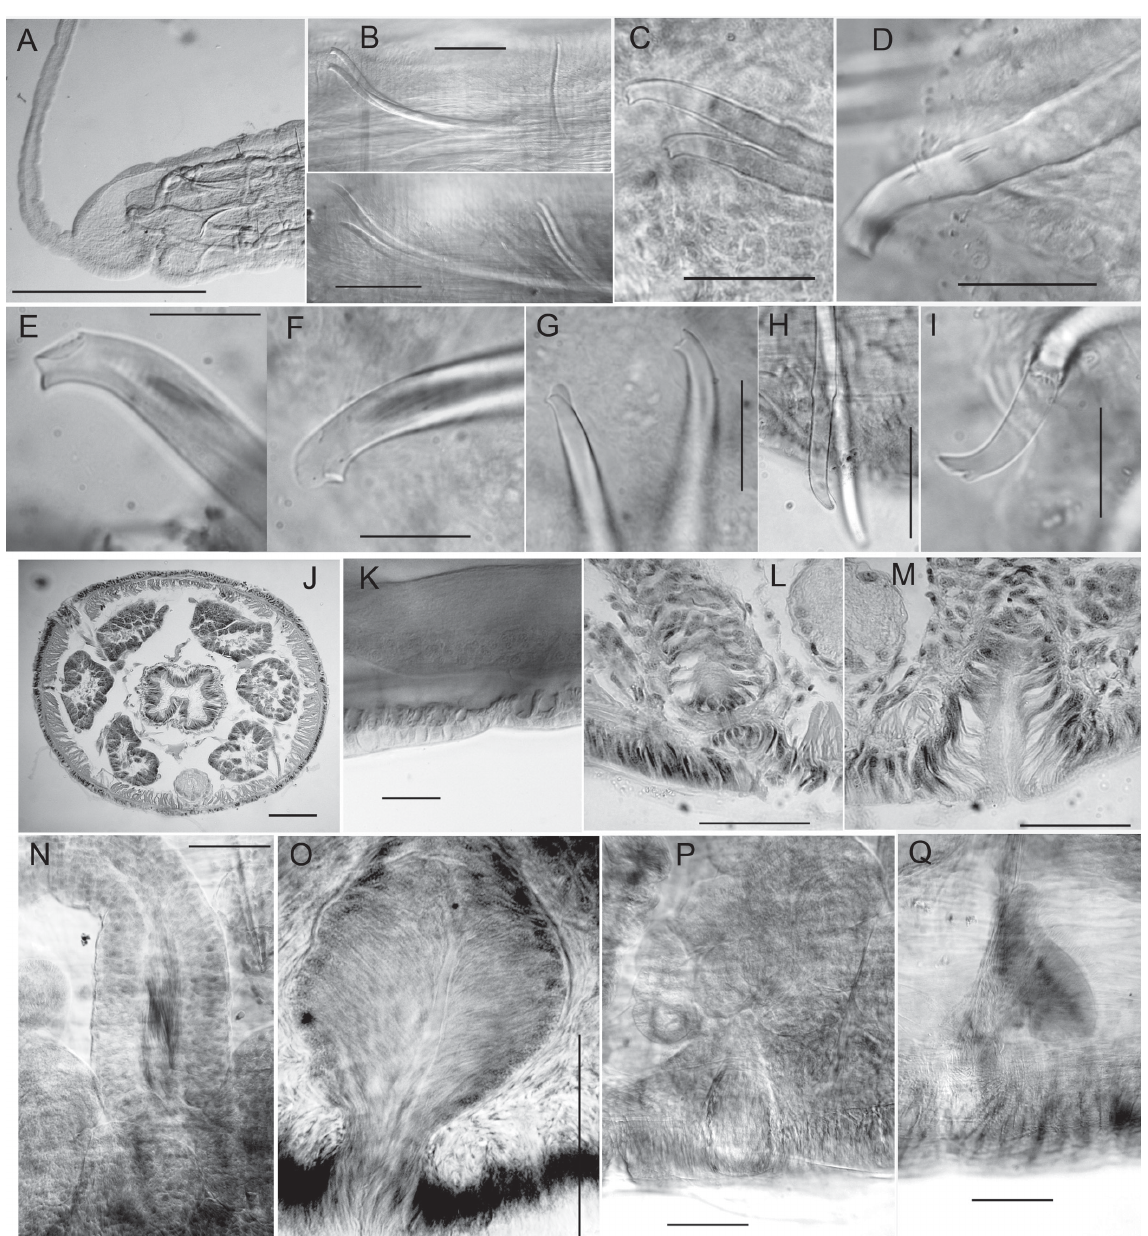
Fig. 12. Guestphalinus elephantinus Fend & Rodriguez sp. nov. A–B (upper) from Clearwater River, WA; C, H, K from Shale Creek, WA (type locality); D–E from Satsop River, WA; B (lower), F–G, N–Q from Guadalupe Creek, CA; I–J, L–M from Peavine Ridge, OR. A . Anterior end of cleared worm. B . Chaetae in II-III, comparing worms from northern (upper) and southern (lower) populations. C . Dorsal chaetae in II. D . The outer chaeta in II, showing the “secondary nodulus”. E–F . Inner dorsal chaeta in II; E shows folded keel. G . Modified dorsal chaetae in II. H . Posterior ventral chaeta. I . Posterior ventral chaeta with bifid tip. J . Transverse section of anterior segment, showing lobes of pharyngeal glands. K . Body wall in anterior segment. L . Spermathecal pore. M . Male pore. N . Ectal part of spermatheca from a dissected, mated worm. O . Expanded atrial duct (type 2 penis?) at male pore. P . Copulatory gland. Q . Female funnel and pore on intersegment 10/11. Scale bars: A = 1 mm; B–I, K–M = 50 µm; J, N–Q = 100